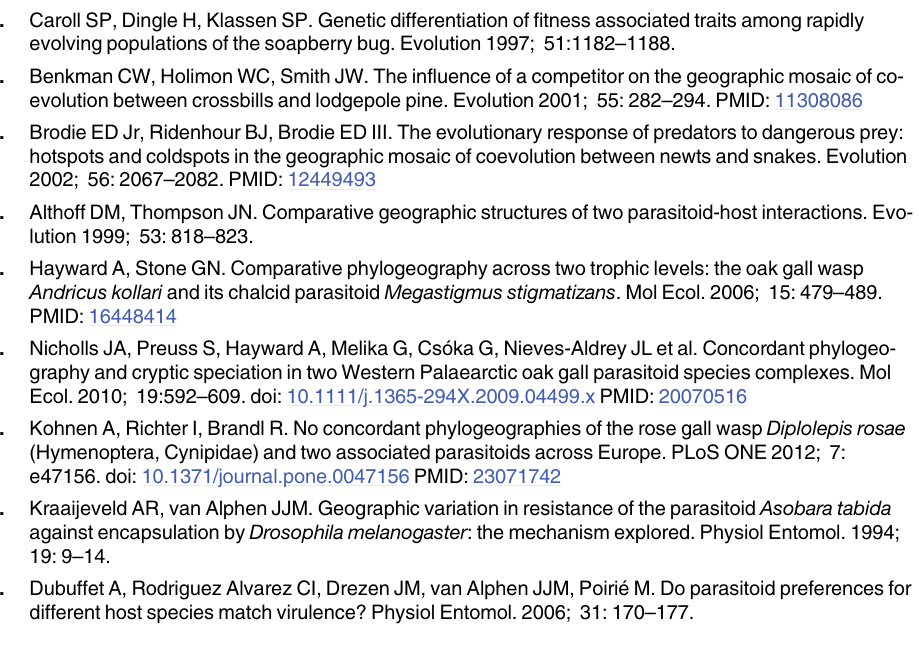
S2 Fig. Correlation analyses of inter-population genetic distance and geographic distance between pairwise populations. S1 Supporting Information. DNA extraction protocol, PCR reaction protocol and the list of primers used for amplification of COI, ITS2 and amplification and disambiguation of